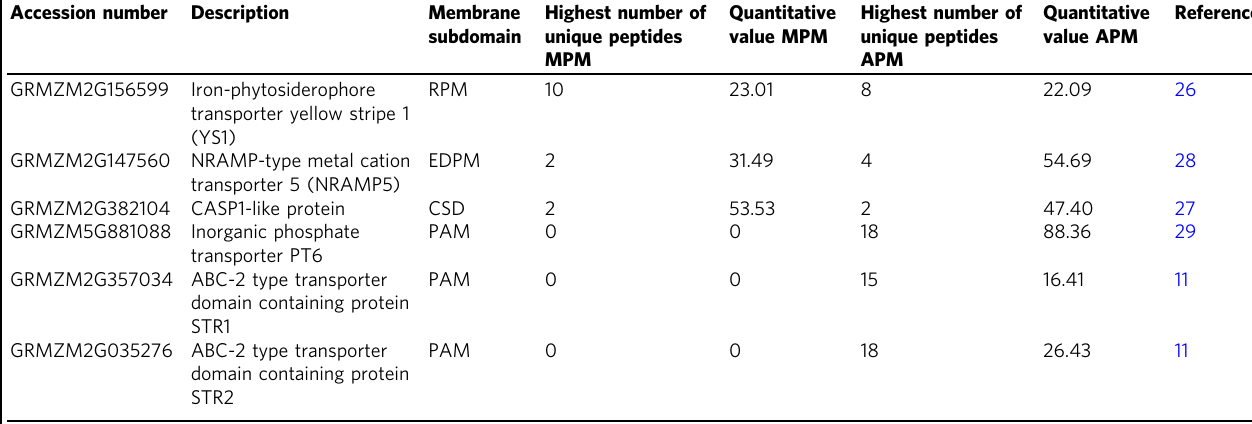
Table 1 Identi fi cation of cell-type-speci fi c marker proteins in mock control and arbuscule-containing maize roots Accession number